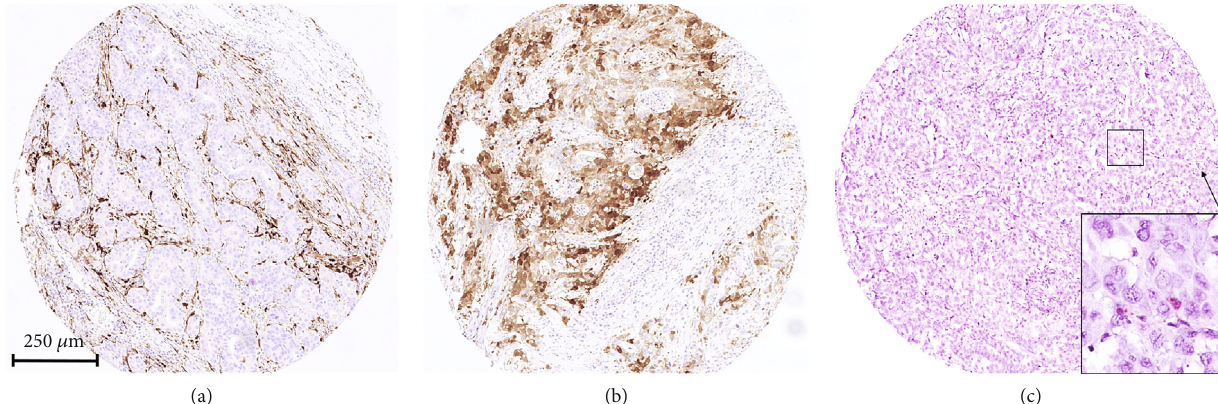
Figure 2: Immunohistochemistry of IDO and INF- γ mRNA analysis: (a) high IDO expression on tumor-in fi ltrating lymphocytes; (b) IDO expression of tumor cells; (c) mRNA of INF- γ (red signals) on tumor cells.